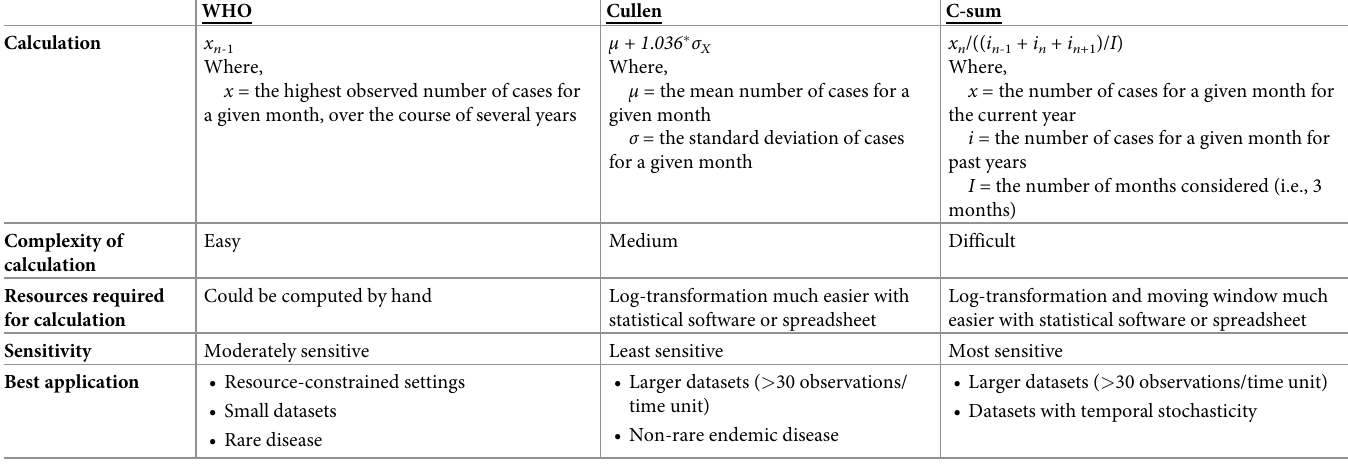
Table 1. Summary of